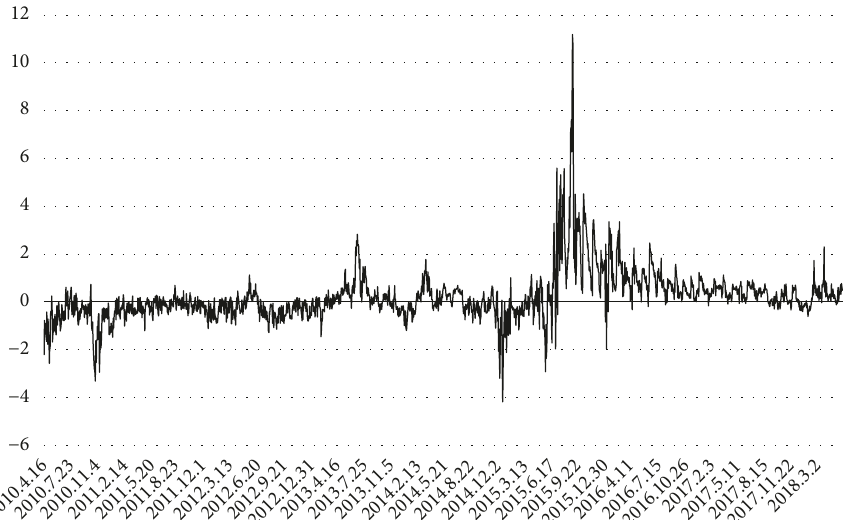
Figure 2: The basis sequence of CSI 300 stock index